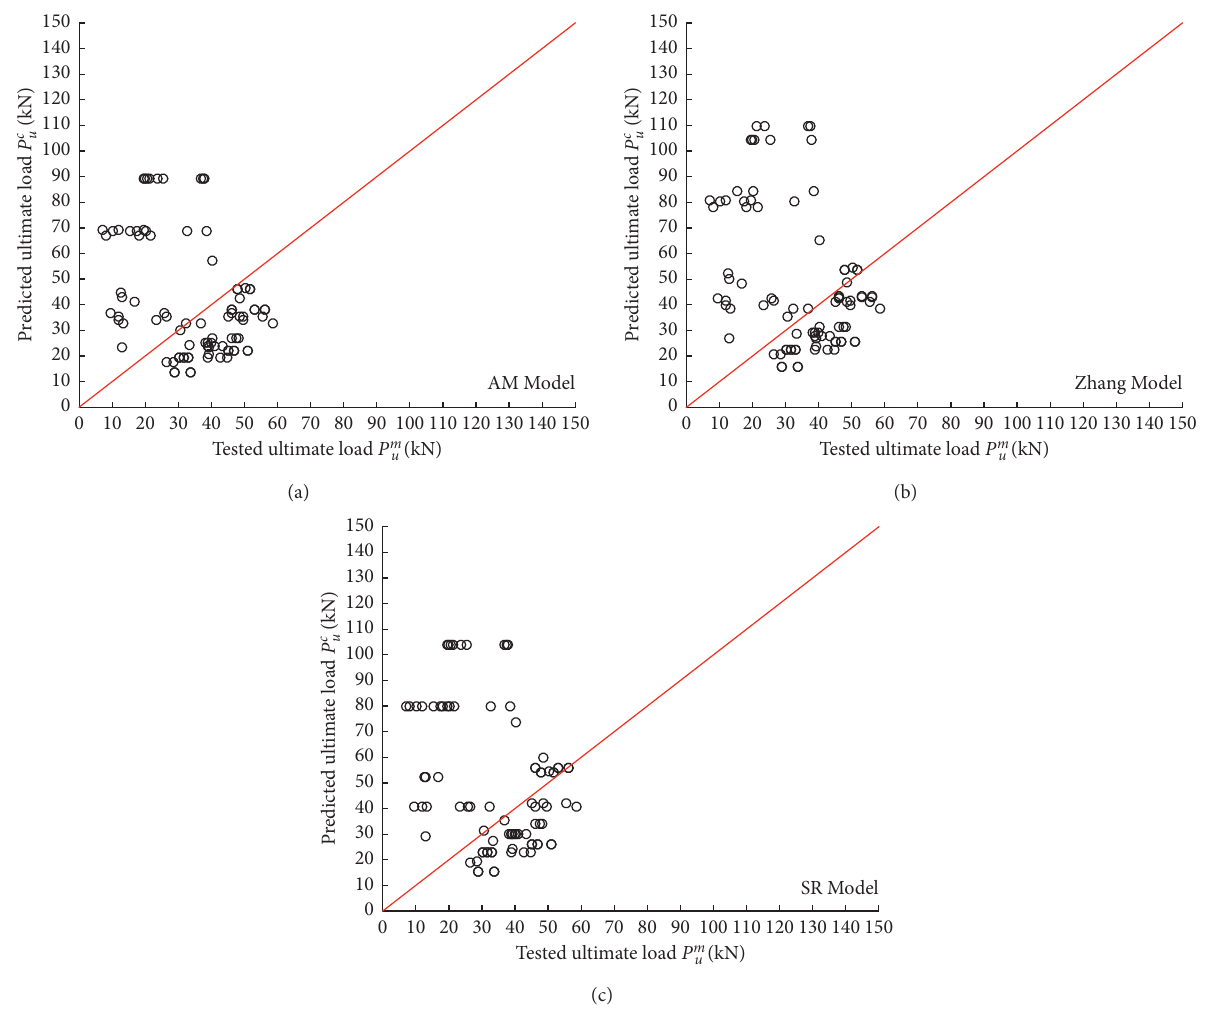
Figure 1: Comparison between the calculated value and the experimental value for the three models under the adhesive-concrete interface failure mode: (a) AM Model, (b) Zhang Model, and (c) SR